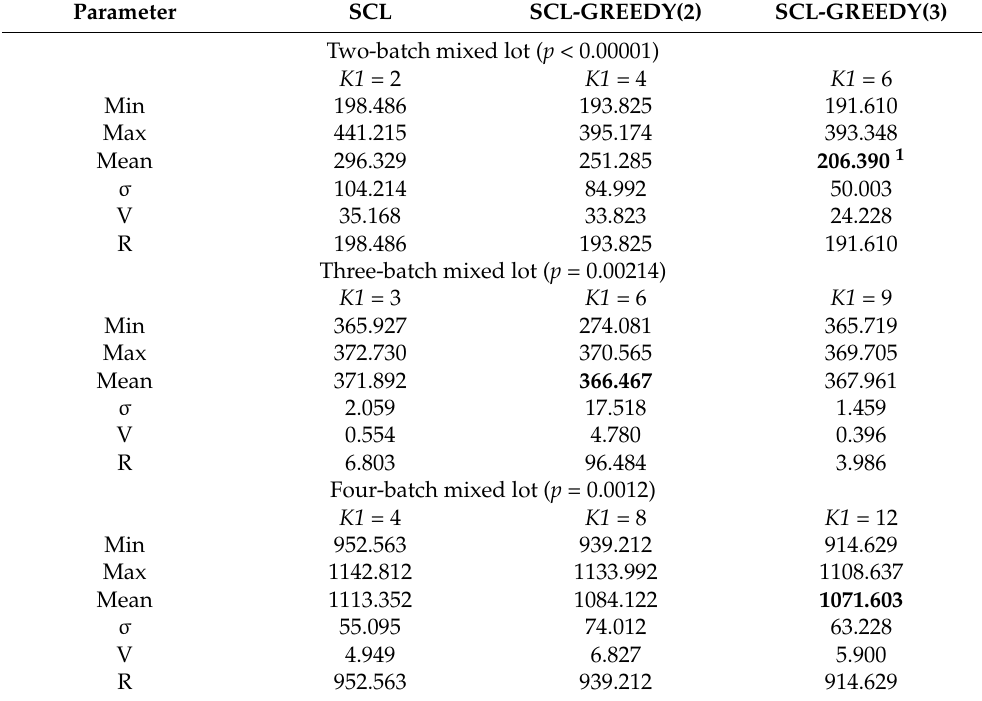
Table 2. Objective function value summarized after 30 attempts (Euclidean distance).